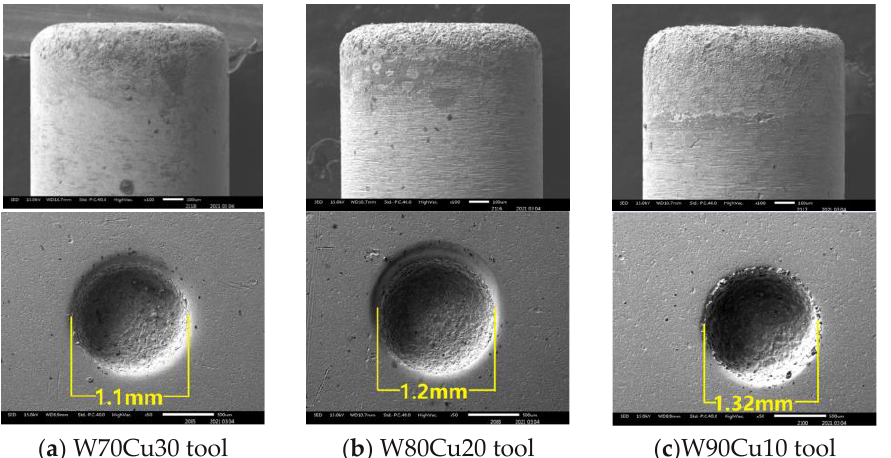
Figure 11. Tungsten–copper tool electrodes’ effect on side overcut under machining conditions T on = 12 μs, T off = 12 μs, I p = 14.17 A.